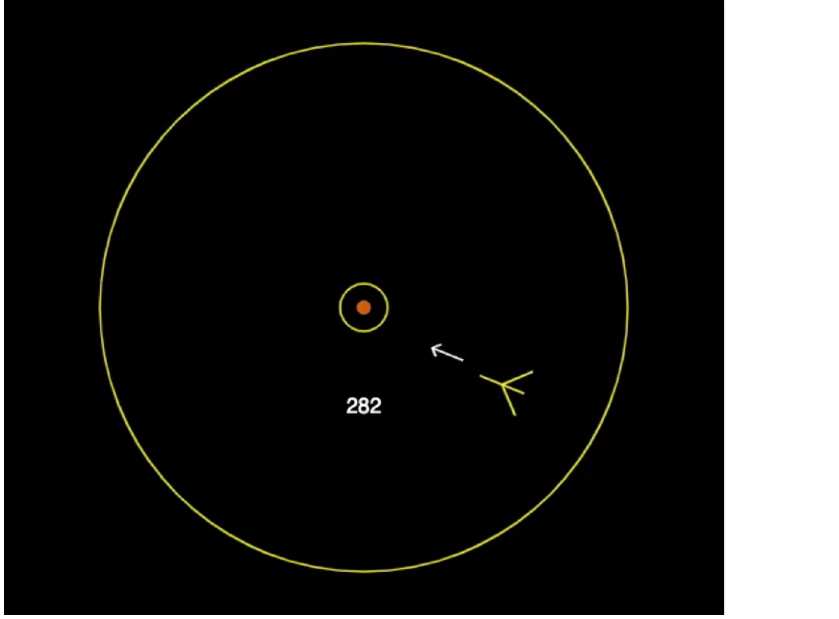
Fig 1. Illustration of the Auto Orbit video game